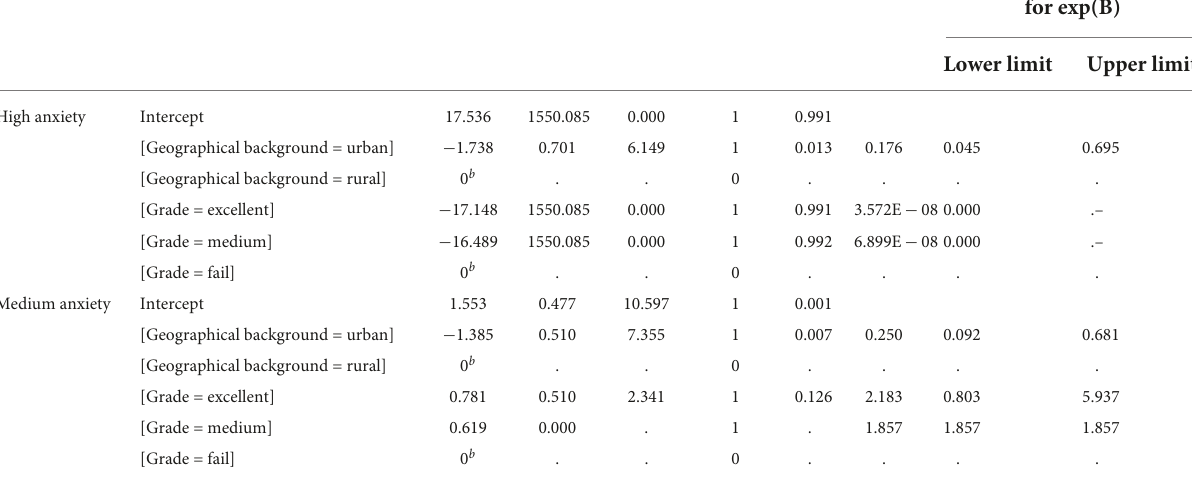
TABLE 9 Parameter estimation with low anxiety as a reference category. Grouping